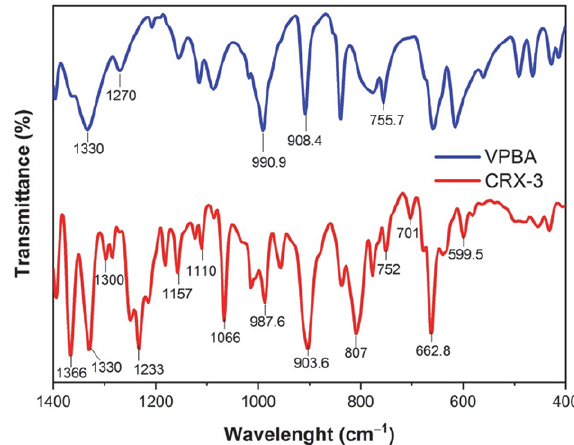
Figure 2. FT-IR spectrum of 4-vinylphenyl boronic acid (VPBA, top) and CRX-3